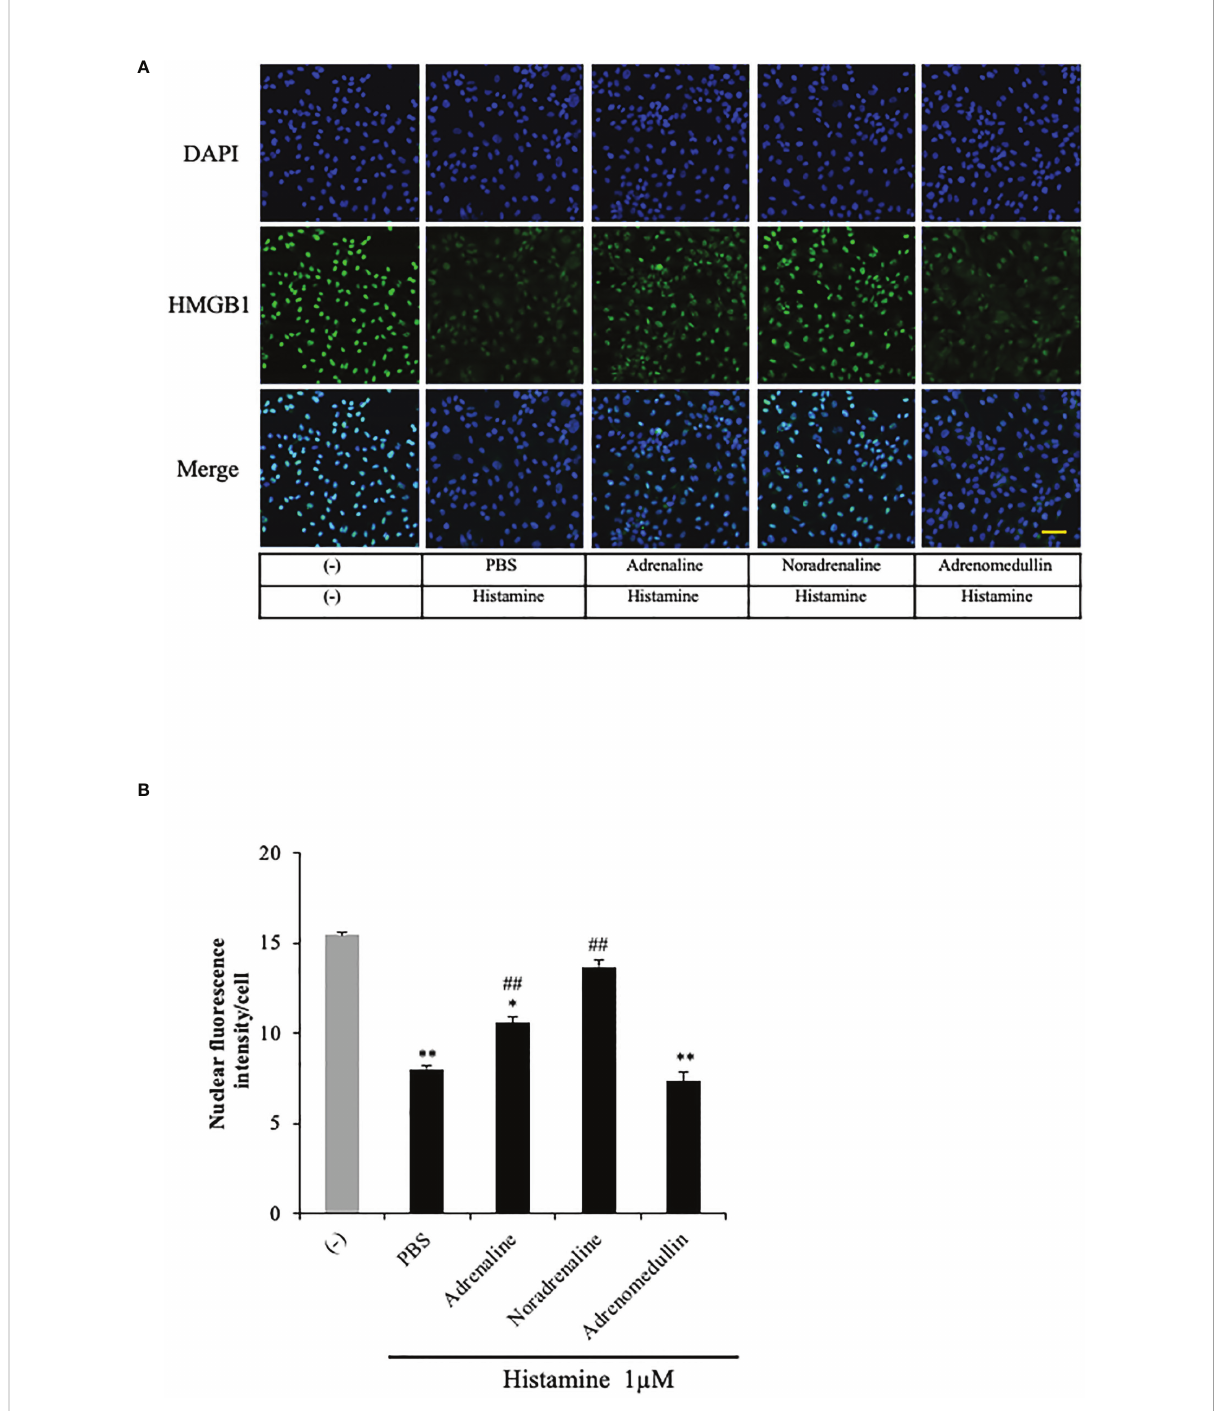
FIGURE 5 Effects of adrenaline and noradrenaline on histamine-induced HMGB1 translocation in VECs. (A) EA.hy 926 cells were preincubated with adrenaline, noradrenaline or adrenomedullin (5 m M) for 1 h before stimulation with histamine (1 m M). The translocation of HMGB1 was determined by immunostaining. The results are representative of ≥ 5 experiments. Scale bar=10 m m. (B) The HMGB1 translocations were quanti fi ed by ImageJ software and expressed as the ratio of nuclear HMGB1 intensity against the total cell number. The results shown are the means±SEM of fi ve different experiments, (n=5 per group). One-way ANOVA followed by the post hoc Fisher test. *p<0.05, **p<0.01 vs. control in the absence of histamine, ## p<0.01 vs. histamine-PBS